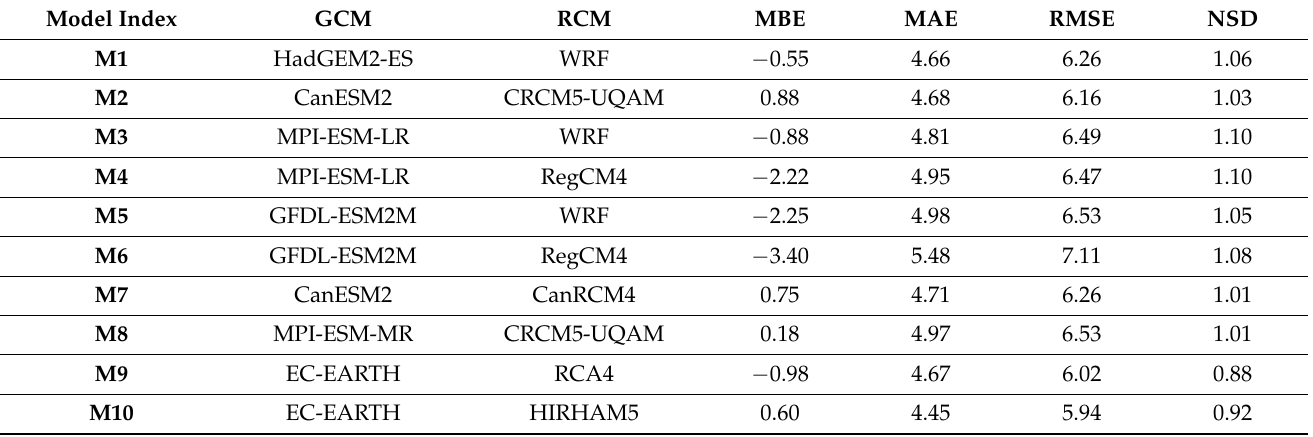
Table 1. Ten combinations of global climate models (GCM) and regional climate models (RCM) from the North American- Coordinated Regional Climate Downscaling Experiment (NA-CORDEX) used in this study. Mean bias error (MBE), mean absolute error (MAE), root mean square error (RMSE), and normalized standard deviation (NSD) in ◦ C are between model simulations and airport observations during 1993 to